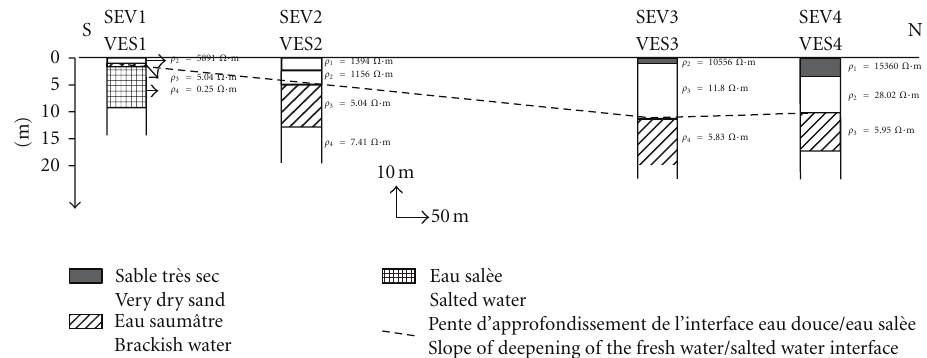
Figure 10: Geoelectrical section on the fresh water/salted water interface.